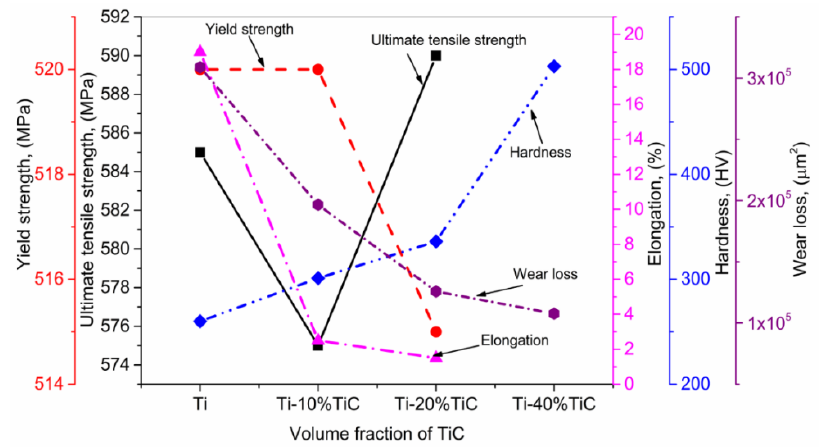
Figure 12. Effect of TiC reinforcement (vol.%) on ultimate tensile and yield strengths, elongation, hardness, and wear loss; based on the data provided in Ref. [146].